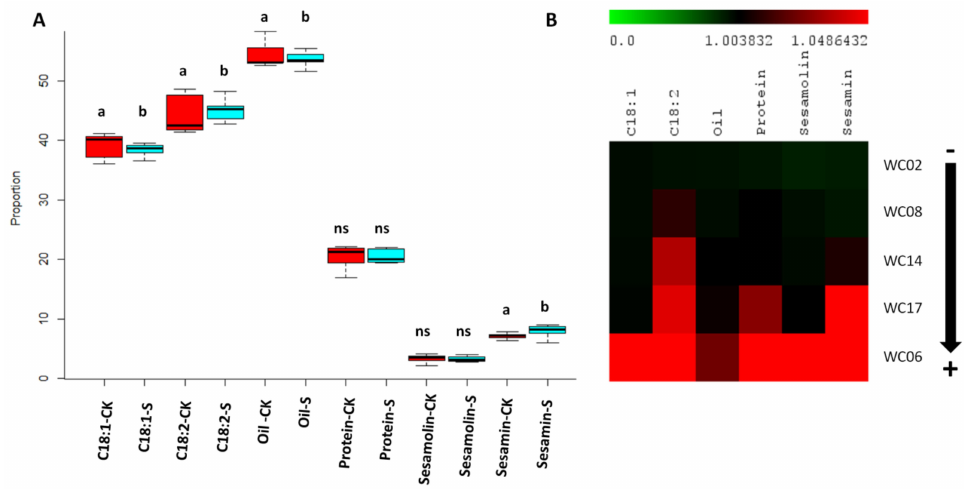
Figure 4. Effects of water deficit on seed quality traits in five sesame genotypes. ( A ) Boxplot comparing values of seed quality traits under well-watered and stress conditions. Boxes in red color are for control samples while boxes in blue color are for stressed samples; ( B ) heatmap and hierarchical sorting of the relative values. Different letters (a, b) above bars represent significant difference ( p < 0.05) between genotypes. “ns” means no significant ( p <